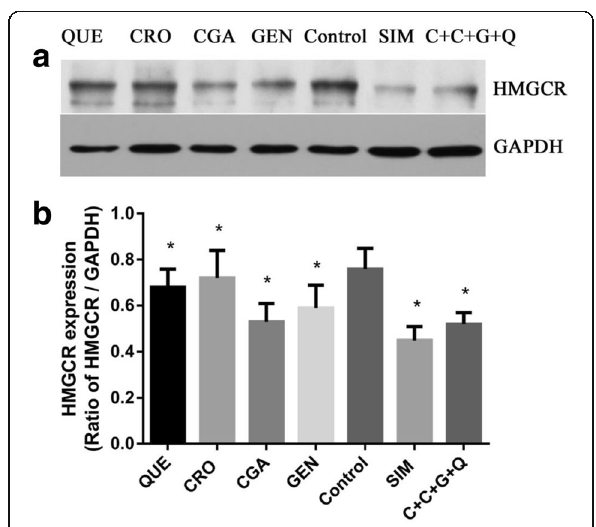
Fig. 6 All drugs and their combination suppress HMGCR protein expression in HepG2 cells. a Western blotting analysis of HMGCR, ( b ) The densitonmetric scanning of HMGCR after normalization with GAPDH. HepG2 cells from 3 set of each group were pooled separately and homogenates was prepared for western blotting analysis of HMGCR. HepG2 cells were treated with QUE (10 μ mol/L), CRO (1 μ mol/L), CGA (30 μ mol/L), GEN (10 μ mol/L), SIM (10 μ mol/L) and C + C + G + Q (1 μ mol/L + 30 μ mol/L + 10 μ mol/L + 10 μ mol/L) for 48 h respectively. Data represent as mean ± SEM of three independent experiments. * P < 0.05 vs.